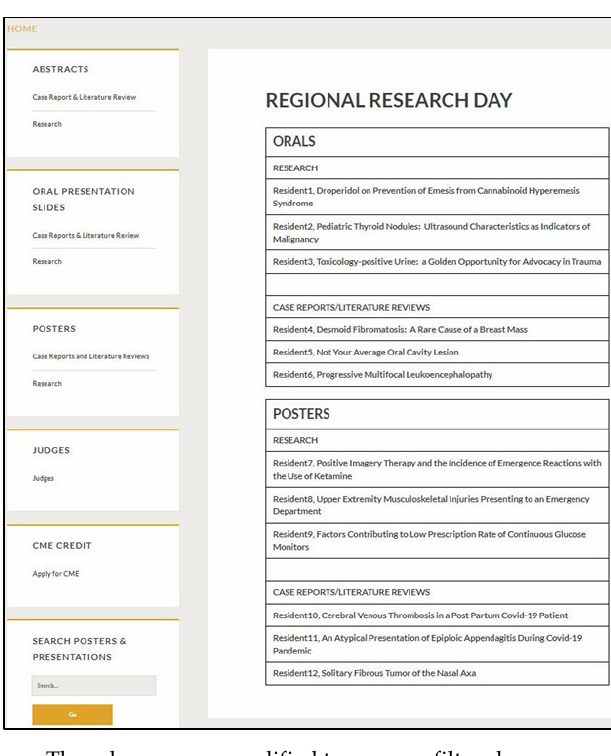
Figure 2 Home page of the public